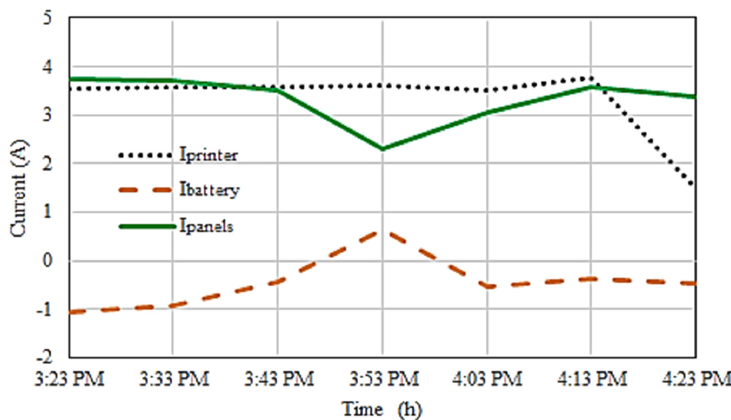
Figure 10. Variation of current across the system during Test 1.